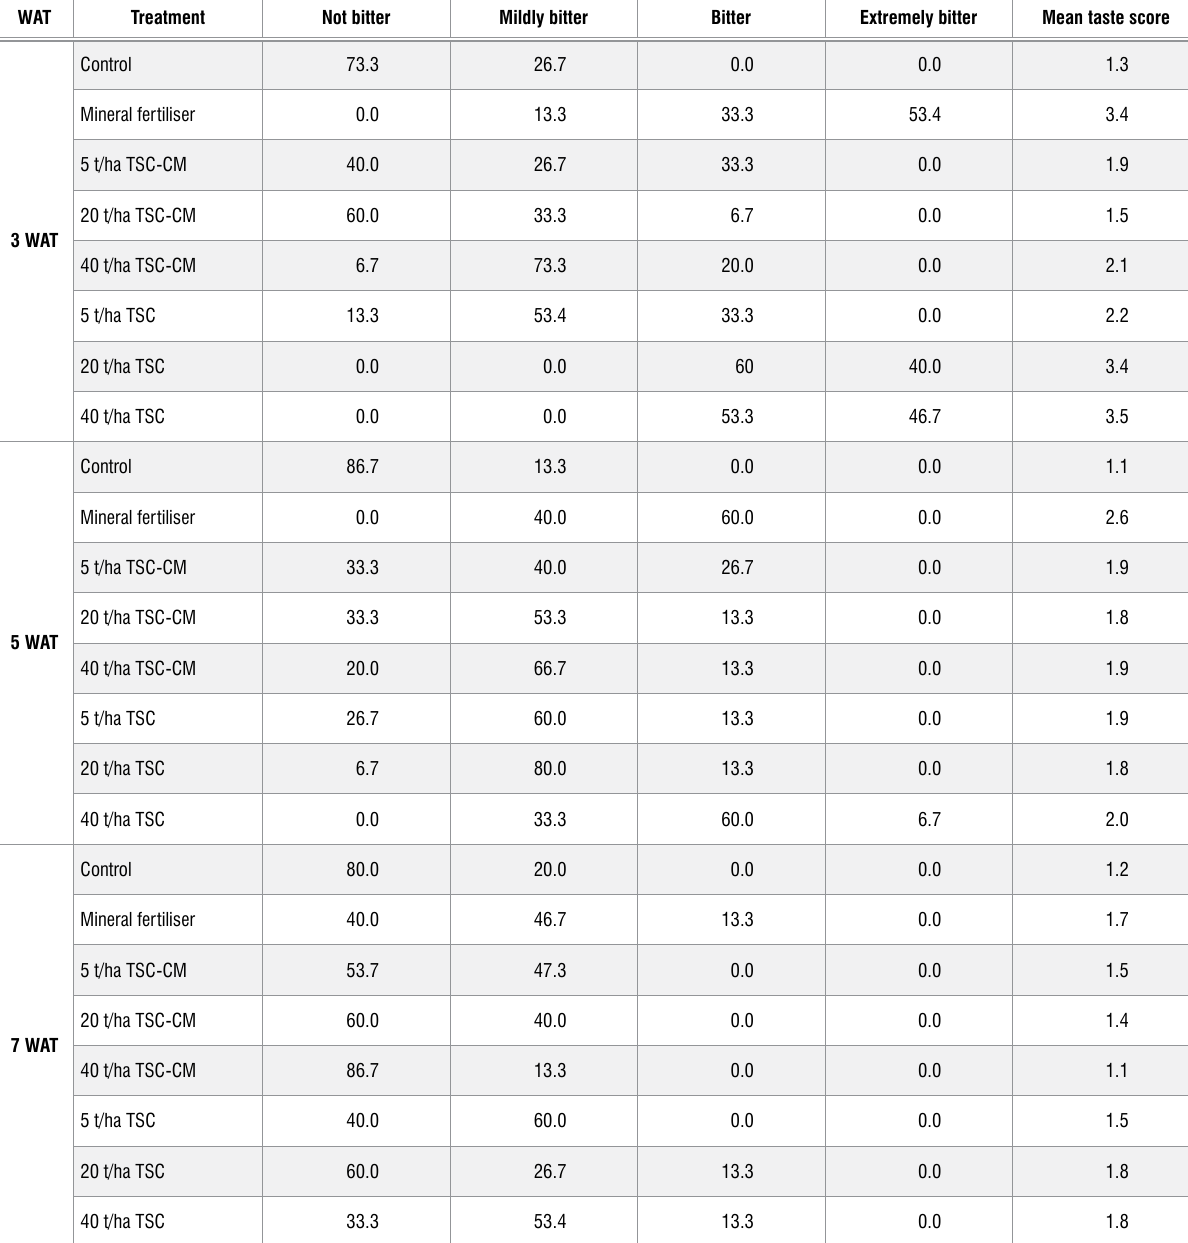
Oilseed rape organoleptic